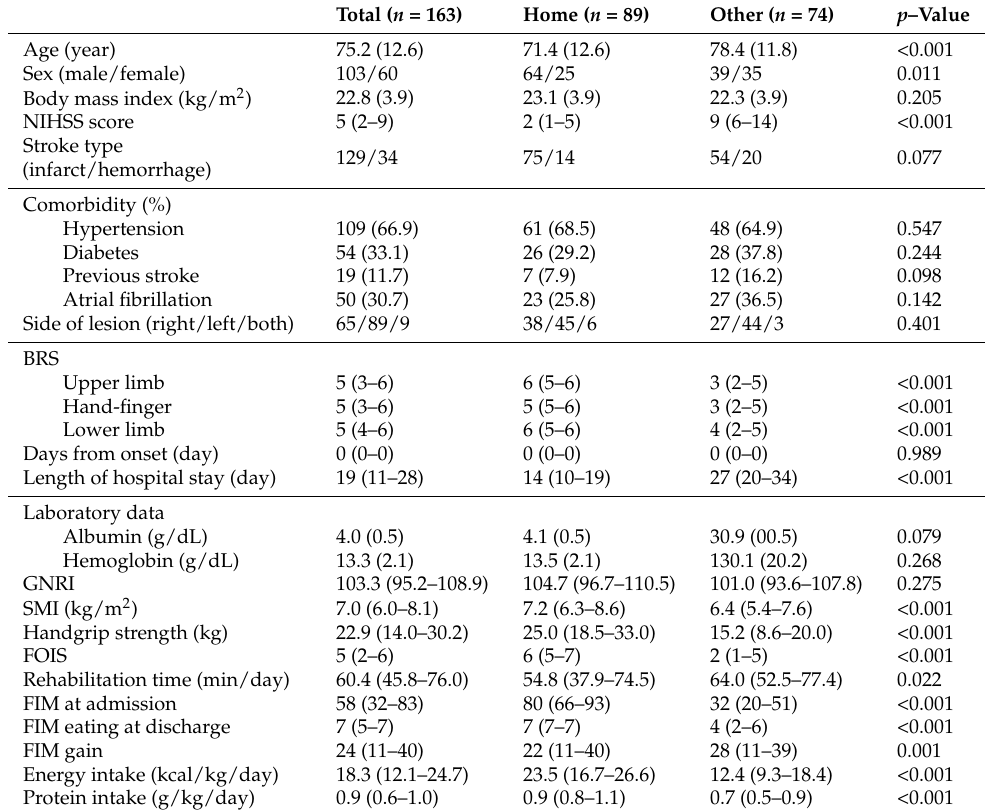
Table 1. Comparison of patient characteristics between the two groups by discharge